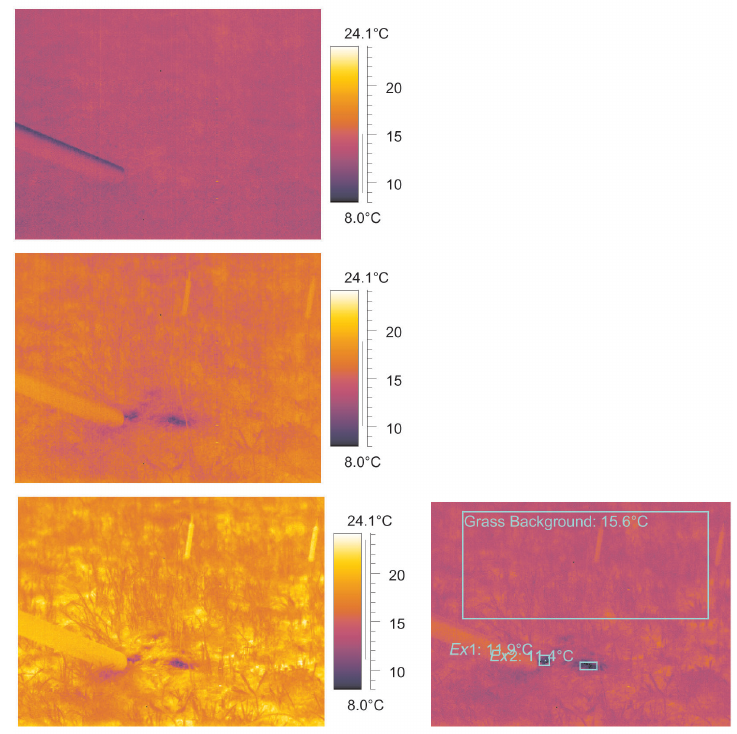
Fig. 6. Temperature distribution at gas release area, top at 09:00 h, middle at 11:30 h, bottom at 12:05 h, right image shows areas outlined from which mean temperatures were